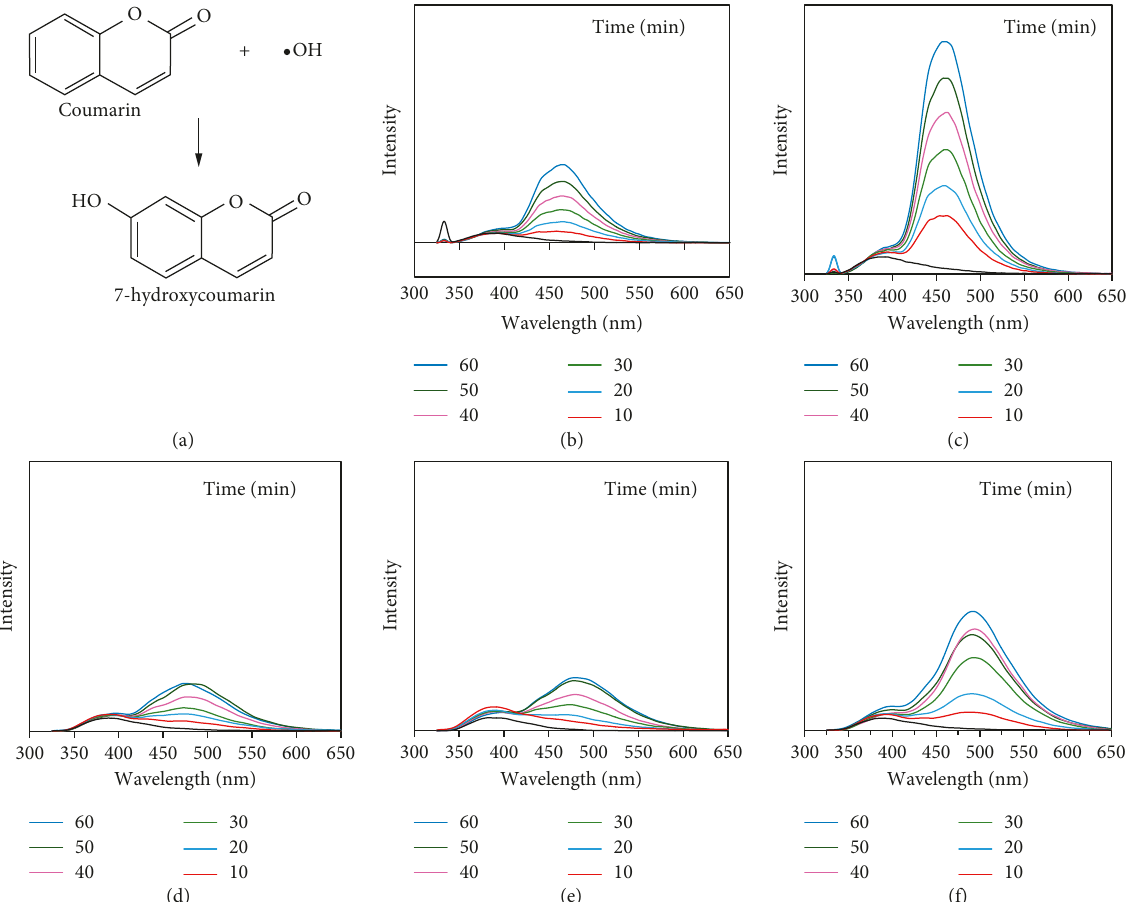
Figure 11: Fluorescence spectra of the 2,4,6-trichlorophenol employed in the detection of OH • generated by photolysis, TiO M3, and M6 photocatalysts without air